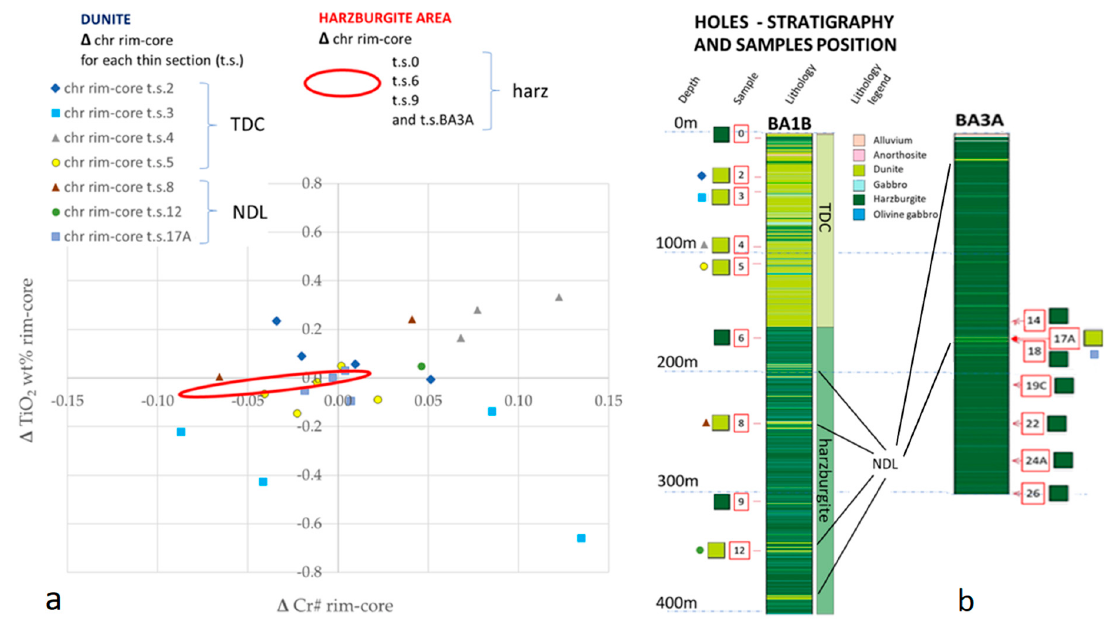
Figure 6. ( a ) Cr# vs TiO 2 diagram, expressed as Δ TiO 2 and Δ Cr# (i.e., as the difference between the rim and the core composition) in each Cr-spinel grain analysed in dunite. The red circle delimits the compositional field of analysed Cr-spinels in harzburgite (t.s. 0,6,9 and t.s. from BA3A), not shown as plotted points. ( b ) BA1B and BA3A stratigraphic columns with samples position (number in red squared and lithology on the side) [28].